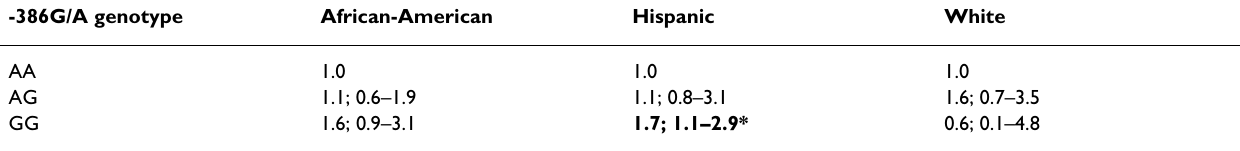
Table 7: Odds ratios for AD as a function of the -386G/A P3 promoter polymorphism stratified by ethnicity -386G/A